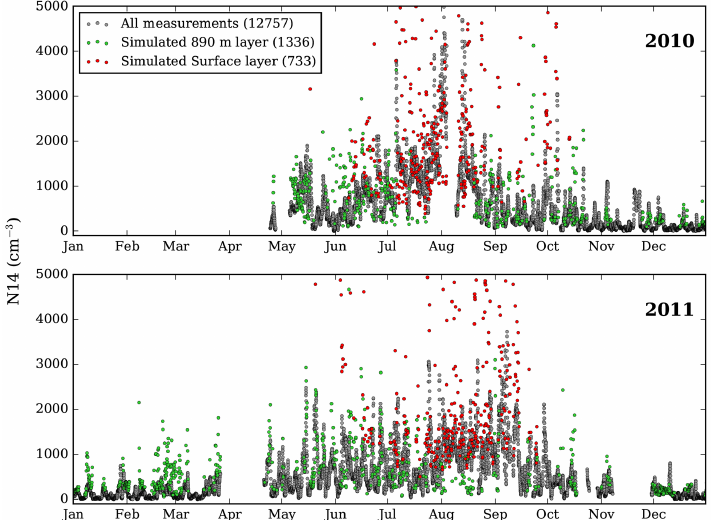
Figure 2. Time series of N14 (the total number of particles with particle diameter, D p , > 14nm) for all measurements (black), and the temperature- and RH-filtered 890m simulated layer (green) and surface layer (red). The bracketed number in the legend corresponds to the total number of data points for each condition.